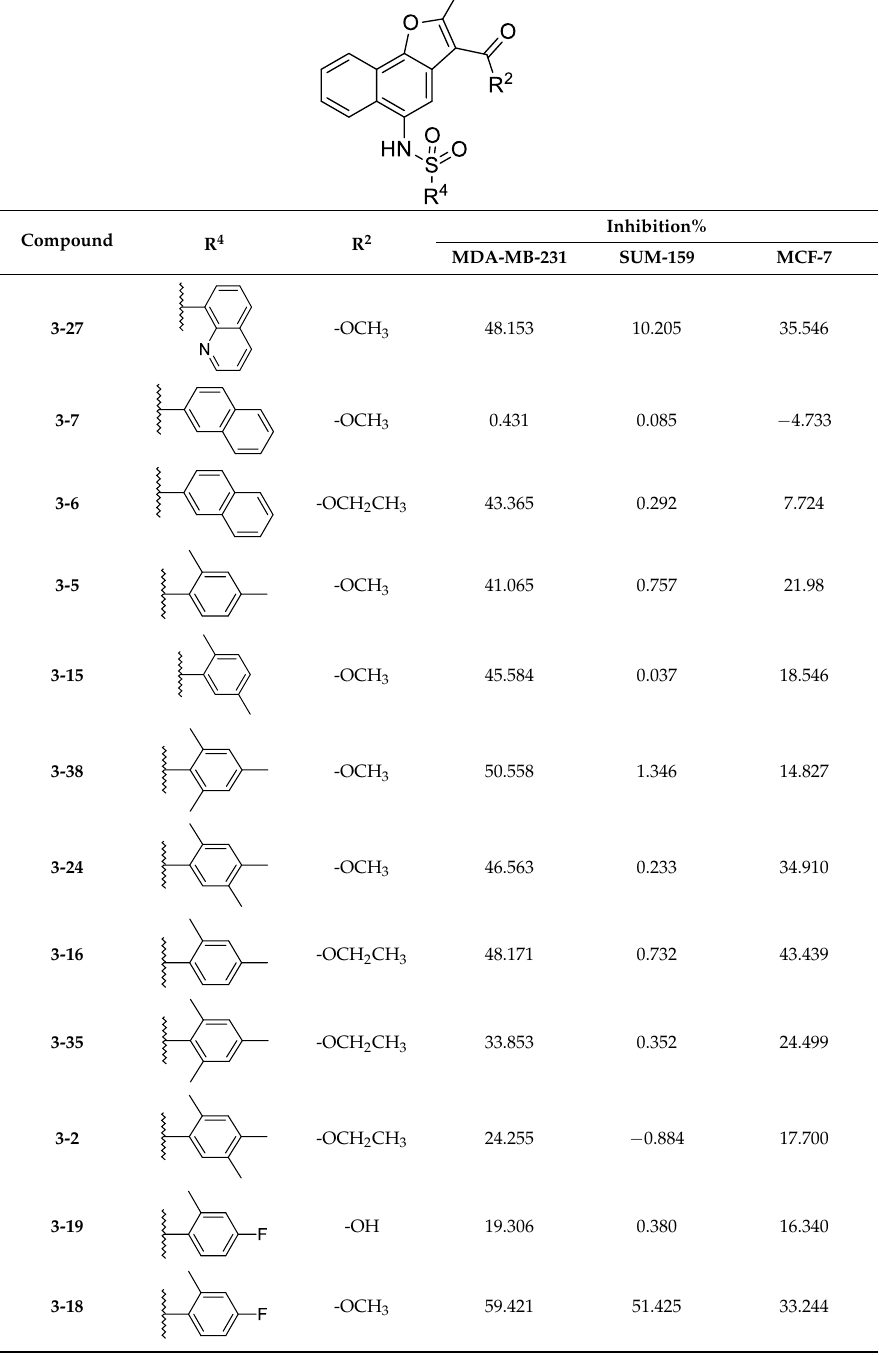
Table 4. Inhibition rates of analogs of 2-5 and 2-8 identified by 2D similarity search (Part 2).